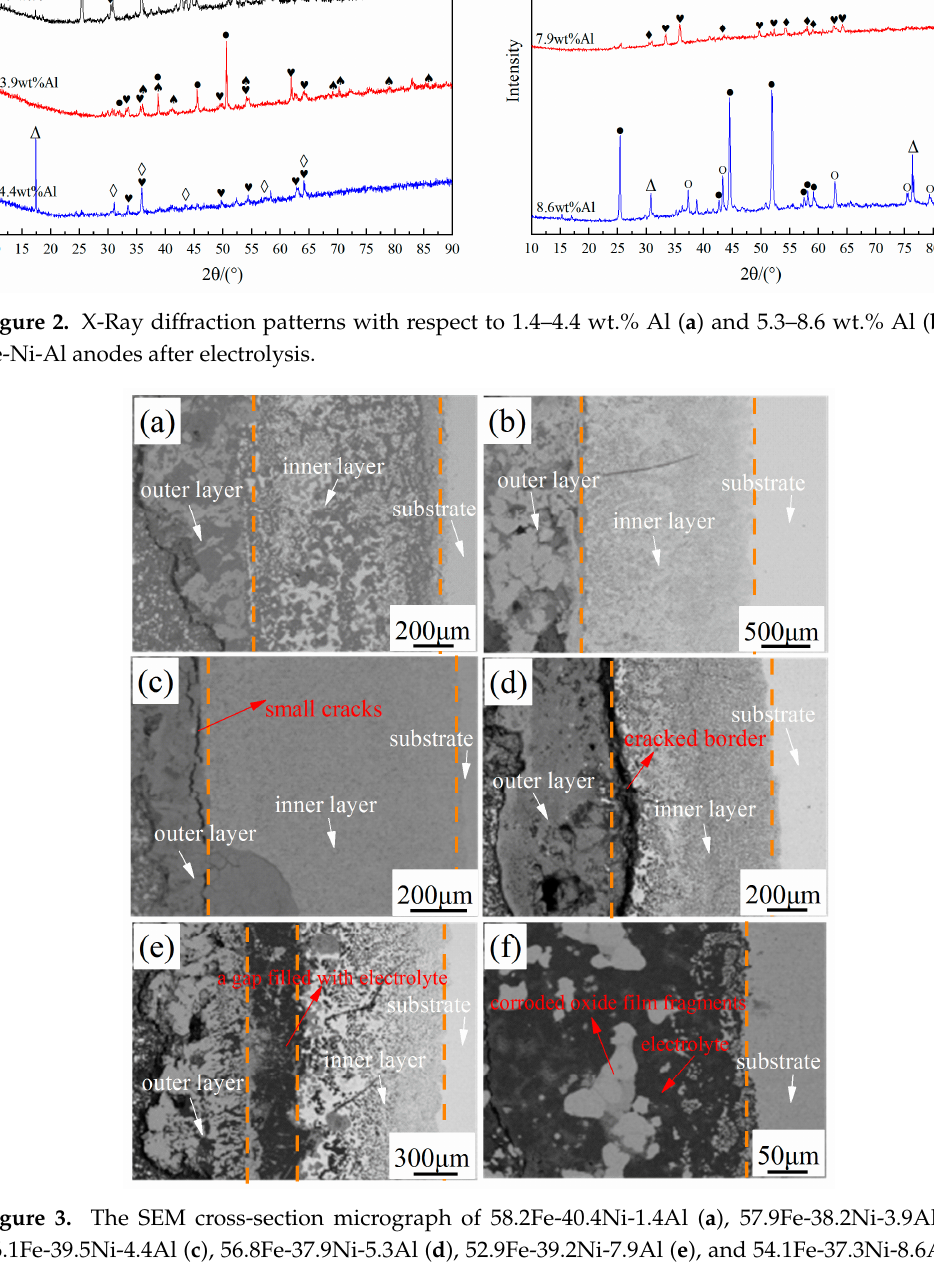
Figure 3. The SEM cross-section micrograph of 58.2Fe-40.4Ni-1.4Al ( a ), 57.9Fe-38.2Ni-3.9Al ( b ), 56.1Fe-39.5Ni-4.4Al ( c ), 56.8Fe-37.9Ni-5.3Al ( d ), 52.9Fe-39.2Ni-7.9Al ( e ), and 54.1Fe-37.3Ni-8.6Al ( f )